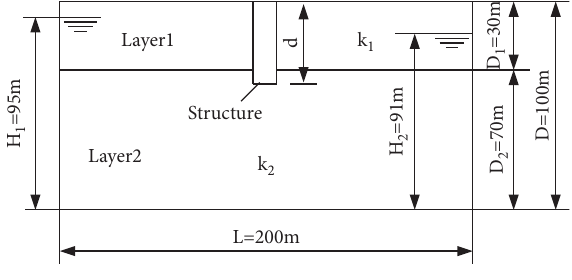
Figure 12: Schematic view of the two-layer